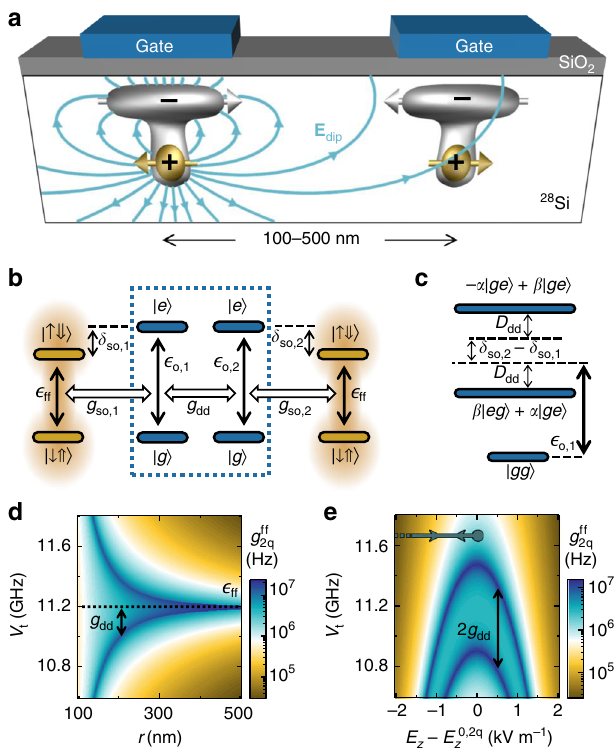
Fig. 5 Robust electric dipole-dipole interactions between two distant fl ip- fl op qubits. a Device scheme for coupling qubits, showing dipole fi eld lines, E dip , produced by the dipole on the left. b Level diagram for two-qubit coupling via electric dipole-dipole interaction. c Lowest molecular eigenstates for the two charge qubits inside dashed rectangle in b . The eigenenergy shift ffiffiffiffiffiffiffiffiffiffiffiffiffiffiffiffiffiffiffiffiffiffiffiffiffiffiffiffiffiffiffiffiffiffiffiffiffiffiffiffiffiffiffiffiffiffiffiffiffi (cid:3) 1 Þ = 2. The equals D dd = ( δ so,2 − δ so,1 ) ð ffiffiffiffiffiffiffiffiffiffiffiffiffi p ffiffiffiffiffiffiffiffiffiffiffi p θ 2 þ 1 ϕ 2 þ 1 eigenstate coef fi cients are β ¼ θ = and α ¼ ϕ = , with Fig. 6b. Smaller detunings δ so (small V t ) result in shorter gate times, which in turn reduces errors from quasi-static noise. coupling between two fl ip- fl op qubits as a function of V t,1 = V t,2 = V t , interdistance r ( d ) and electric fi eld E z ,1 = E z ,2 = E z ( e ). The arrows in e represent the adiabatic path followed for two-qubit gates. E 0 ; 2 q z is the ionization point in the presence of a second qubit, E 0 ; 2q z